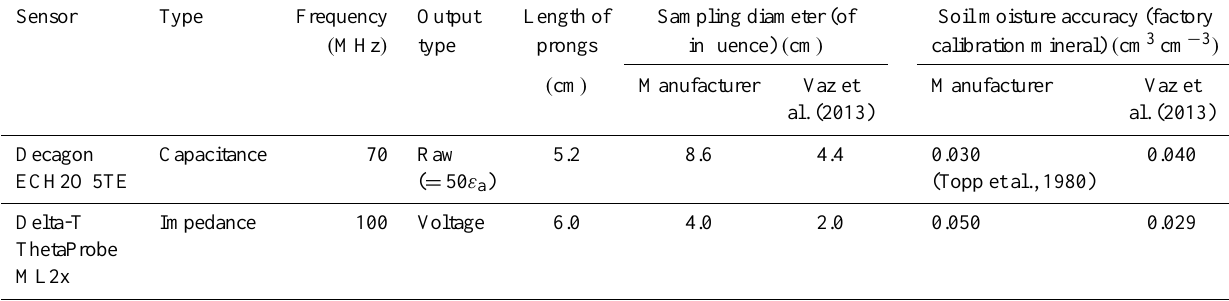
Table 3. Soil moisture sensor characteristics from manufacturer manuals as well as findings of Vaz et al. (2013). Sensor Type